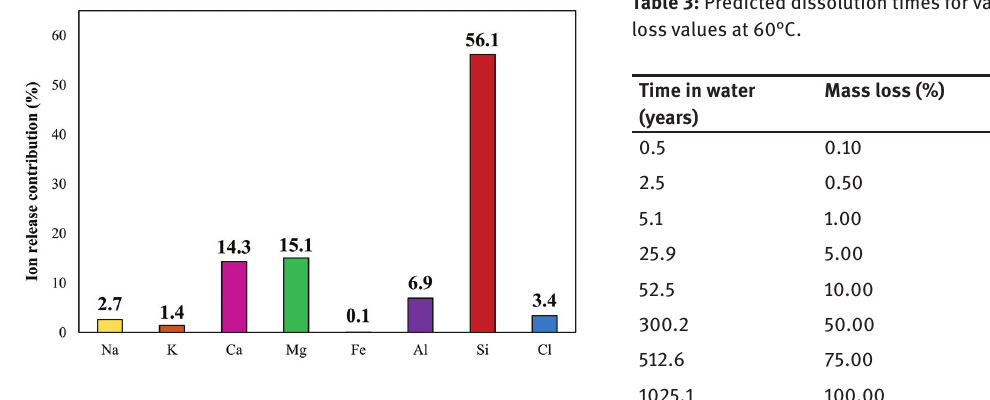
Figure 4: Comparison of ion release rates in the steady-state (values have been calculated from the rate constants in the steady-state).